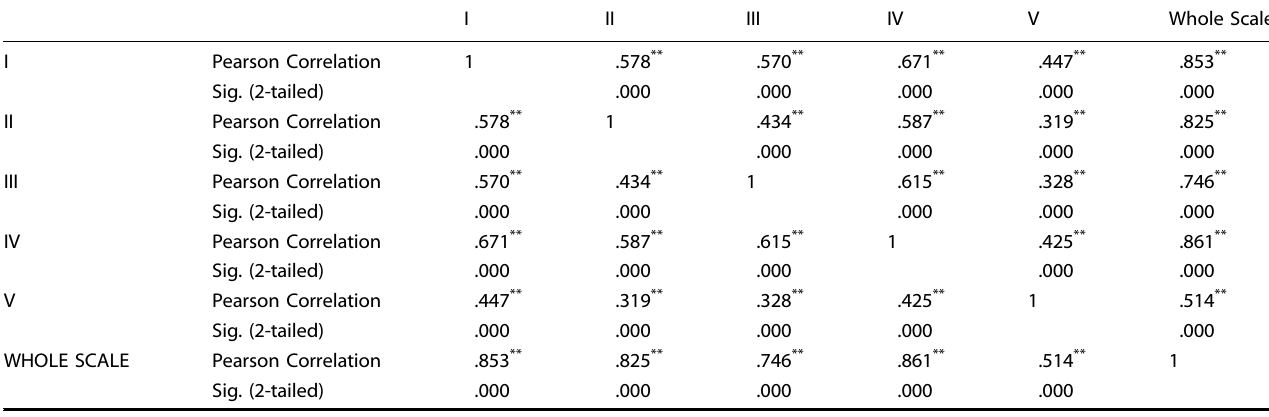
Table 1. Inter-domain correlation of the different domains of the XDP – MDSP scale (I: dystonia; II: parkinsonism; III: non-motor features; IV: activities of daily living; V: overall